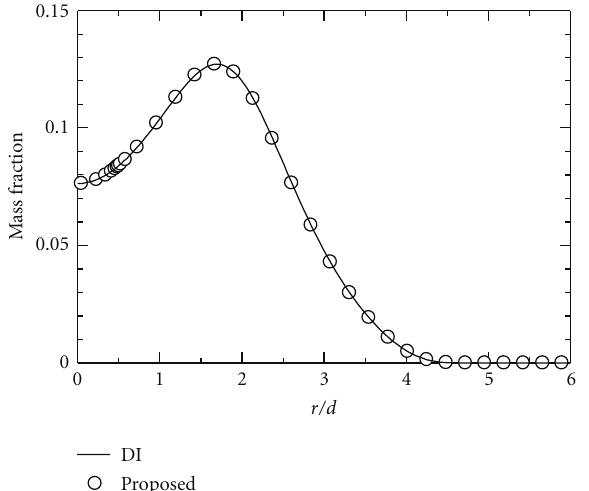
Figure 11: Radial mass fraction of CO 2 at x/d = 20.